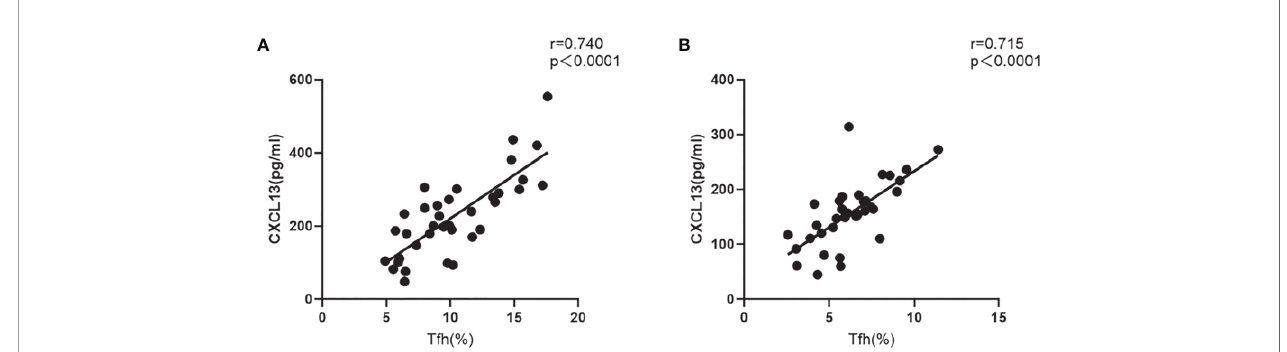
FIGURE 3 | Correlation between the circulating Tfh cell ratio and serum CXCL13 levels in NMOSD patients. (A) acute stage; (B) recovery stage (r: correlation coef